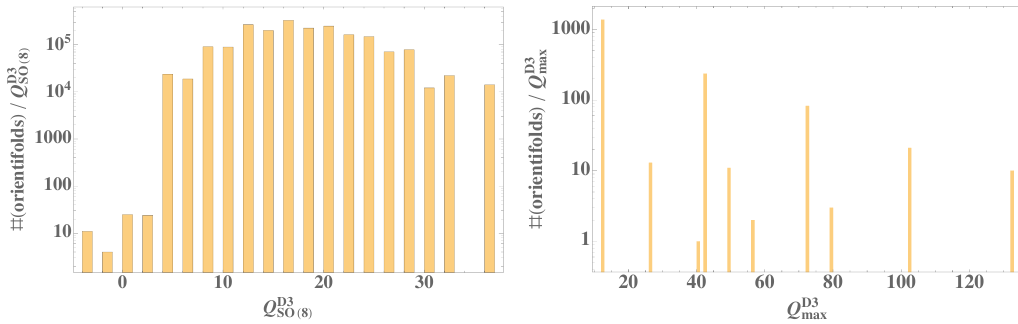
Figure 4 . Left: histogram showing the number of orientifolds with given D3-tadpole (cid:0) Q D 3 (cid:31) f = 4 for local D7-charge cancellation. The tadpole takes even values in [ (cid:0) 4 ; 36]. Right: D3-tadpole for a small set of examples with non-local tadpole cancellation by a generic D7-brane. We have restricted ourselves to the subset of smooth CICYs where the O7 divisor obviously descends from an ambient space divisor. The tadpole takes even values in a signi(cid:12)cantly larger range [12 ; 132].